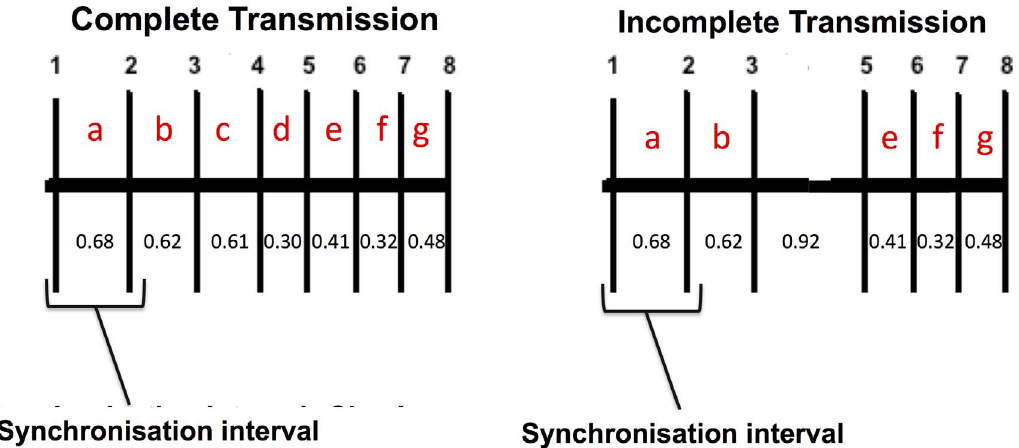
Figure 2. Complete vs. incomplete transmission. VMT transmissions comprise a series of 8 acoustic pings. Each oustic ping stringontains a synchronization interval (between the first two pings), used to identify acoustic-tag transmission format, followed by a series of pings unique to each individual tag. Intervals between 0.30–0.70 s correspond to consecutive pings. An interval between 0.70–1.50 s may indicate that one ping (of duration 0.01 s) is missing, e.g. time interval of 0.92 s in the incomplete transmission diagram. All 8 acoustic pings must be received for a detection to be recorded.